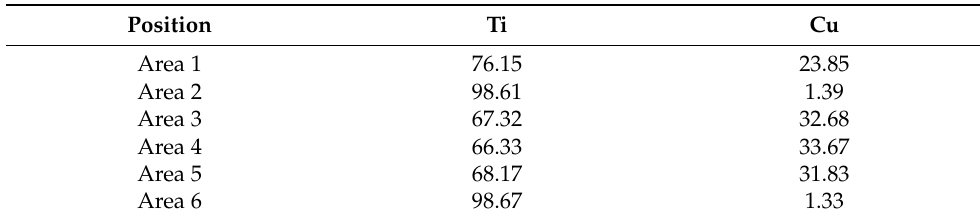
Table 3. EDS analysis results of the Ti 2 Cu and α -Ti phases in Ti-xCu alloys marked in Figures 6 and 7